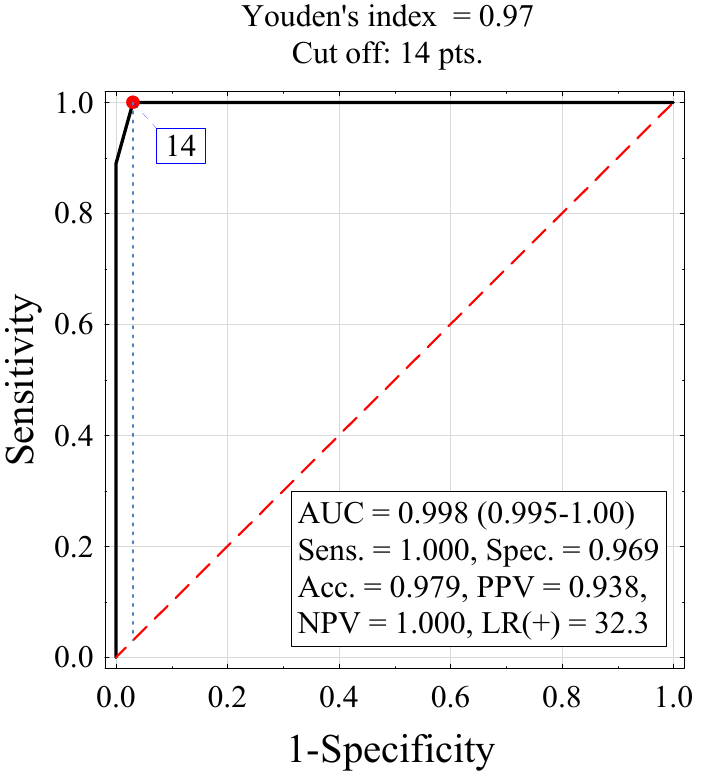
Figure 2. An ROC curve for identifying a high risk of work disability based on the score on the shortened version of the AS-WIS (AS-WIS-16). AUC—area under the curve, Sens.—sensitivity, Spec.—specificity, Acc.—accuracy, PPV—positive predictive value, NPV—negative predictive value, LR(+)—likelihood